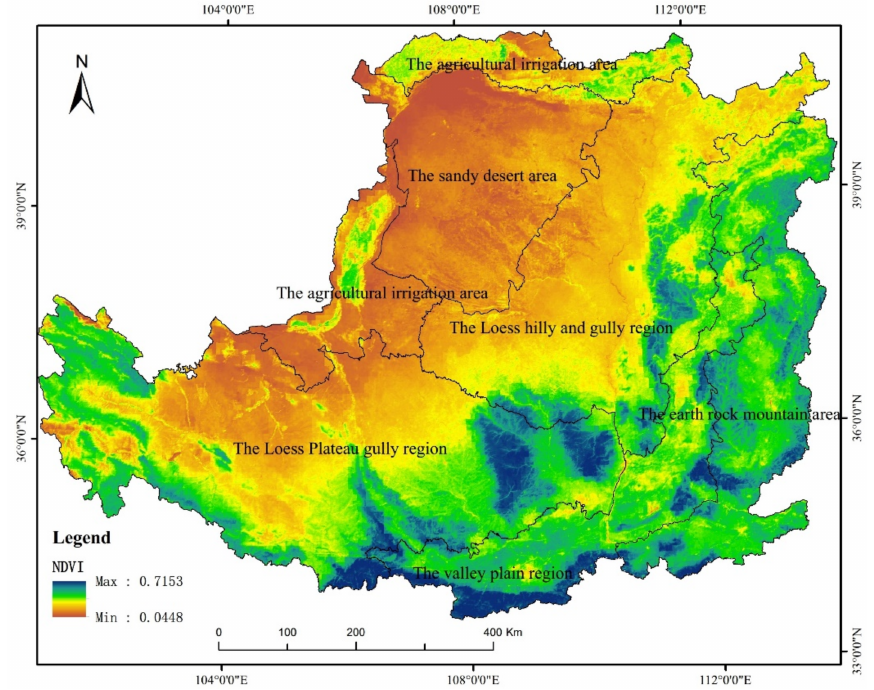
Figure 4. Average NDVI distribution on the Loess Plateau from 1990 to